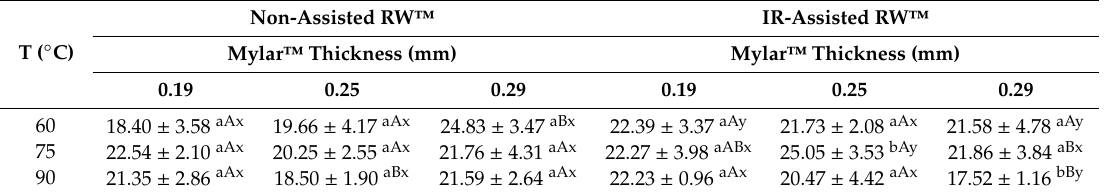
Table 6. Changes in a* coordinate values of dried Physalis pur é e subjected to di ff erent RW ™ drying conditions.